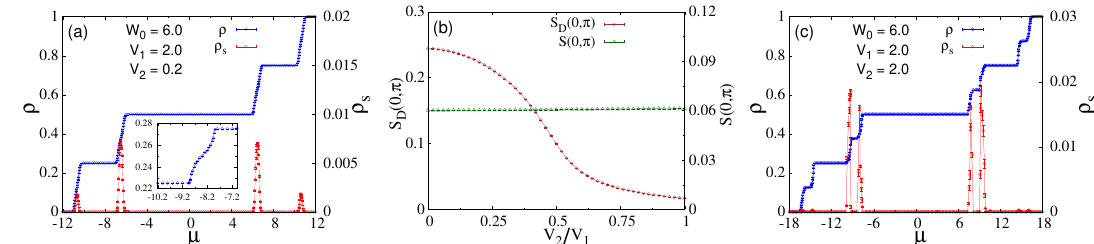
Figure 11: Variation of the density versus chemical potential in the presence of both NN repulsion V and NNN repulsion V 1 = 2.0, V = 0.2, and (c) V for (a) V 1 2 factor and structure factor with the ratio V